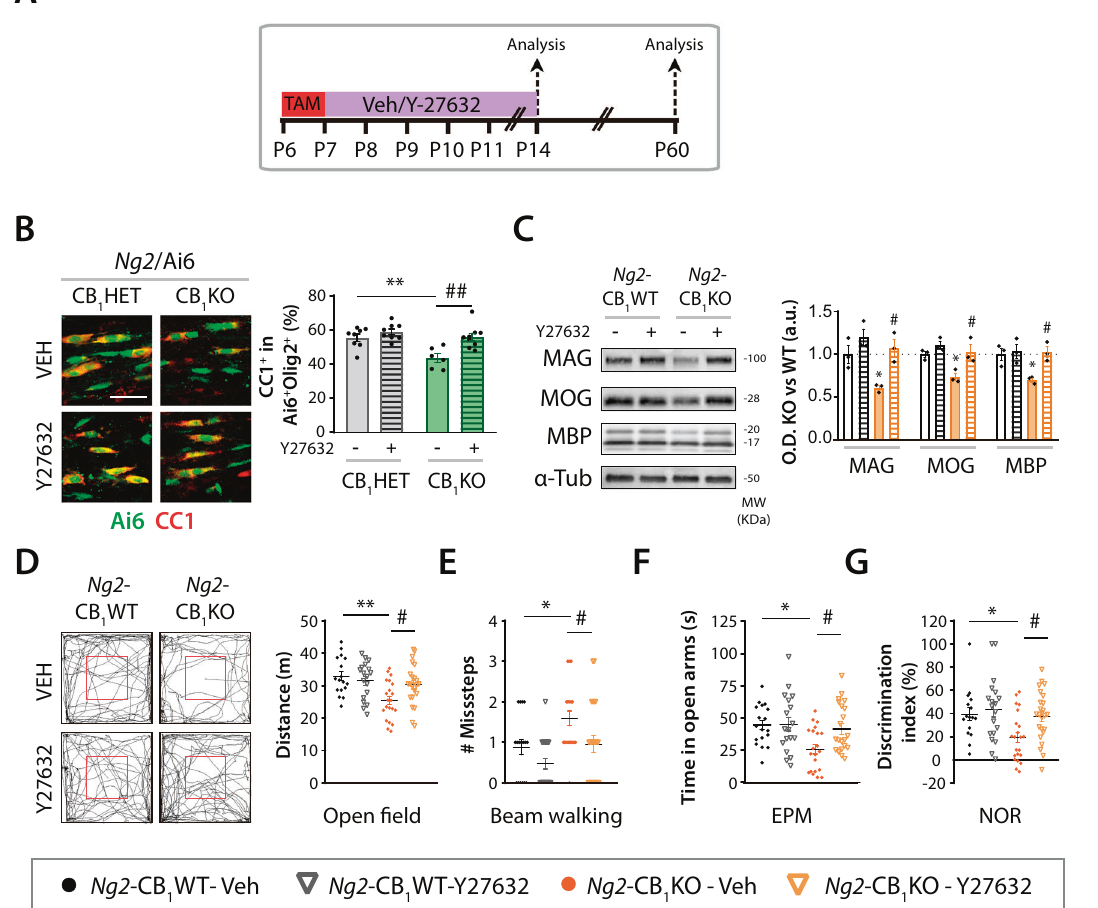
Fig. 6 Pharmacological inactivation of ROCK overcomes the defects in oligodendrogenesis and myelination of CB 1 de fi cient OPC. A Tamoxifen-driven recombination was induced at postnatal day 6 (P6-P7) in Ng2 -CB 1 KO, Ng2 -CB 1 WT, Ng2 /Ai6-CB 1 KO and Ng2 /Ai6-CB 1 HET mice followed by administrations of the ROCK inhibitor Y-27632 (10 mg/kg), and tissue was analyzed at P11 or P60. B Immuno fl uorescence analysis and quanti fi cation of the percentage of CC1 + oligodendrocytes among the recombinant Ai6 + Olig2 + population at P11. C Western blot analysis of the myelin associated proteins, myelin-associated glycoprotein (MAG), myelin oligodendrocyte glycoprotein (MOG), and myelin basic protein (MBP) in corpus callosum extracts at P60. Quanti fi cation of optical density (O.D.). D – G Behavioral analysis of Ng2 -CB 1 KO and Ng2 -CB 1 WT mice at P60. D Open fi eld test. Representative images of mouse trajectories. Quanti fi cation of total distance travelled. E Beam walking test. Quanti fi cation of missteps. F Elevated plus maze (EPM) test. Quanti fi cation of the time spent in open arms. G Novel object recognition (NOR) test. Quanti fi cation of the discrimination index. Data are shown as mean ± SEM. n = 6 – 9 for B , n = 3 for C , 16 – 24 for D – G , independent data points were used for each experimental group. * p ≤ 0.05, ** p ≤ 0.01 vs Veh-treated Ng2 /Ai6-CB 1 HET or Ng2 -CB 1 WT mice; # p ≤ 0.05, ## p ≤ 0.01 vs Veh-treated Ng2 /Ai6-CB 1 KO mice or Ng2 -CB 1 KO mice by two-way ANOVA followed by Tukey´s multiple comparisons. Scale bar, 20 µm in B